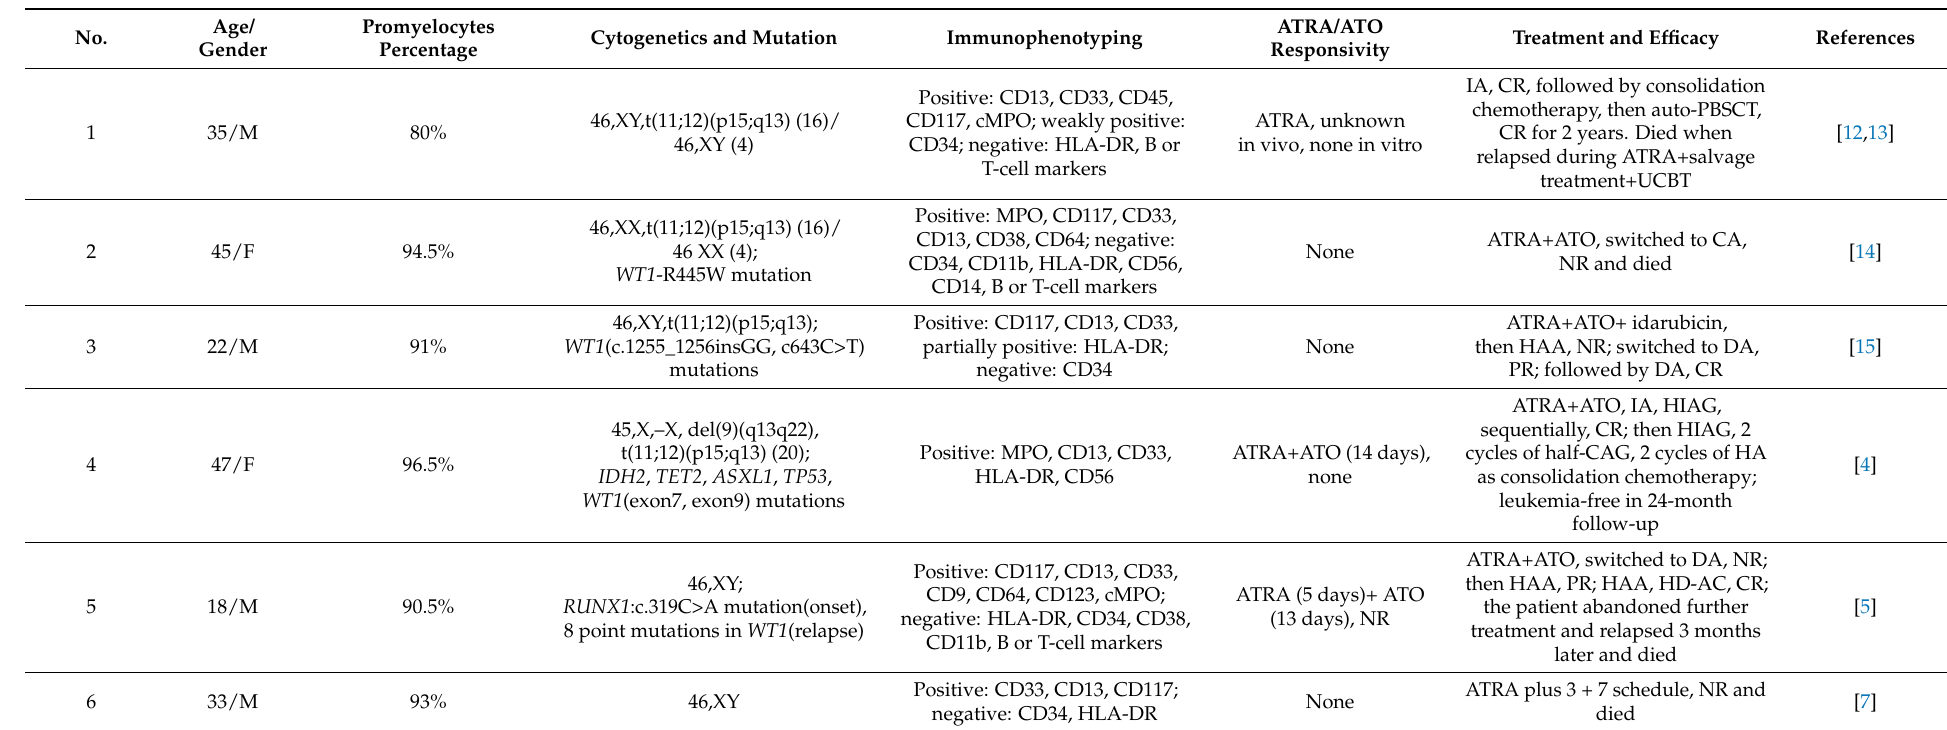
Table 2. Cases of APLL harboring